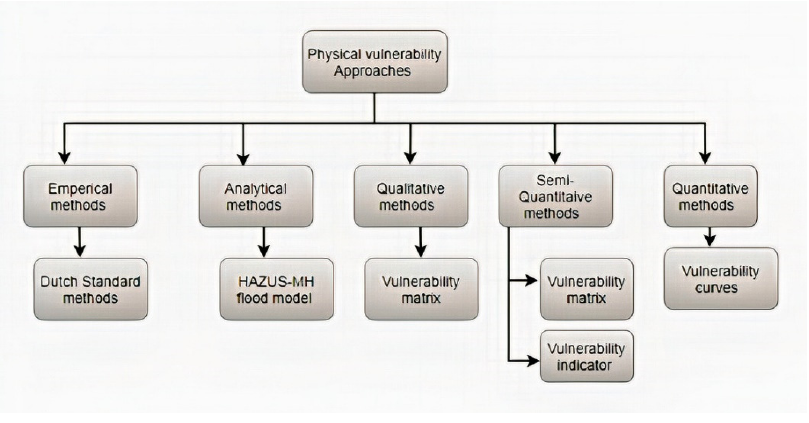
Figure 3. Different types of physical vulnerability approach.